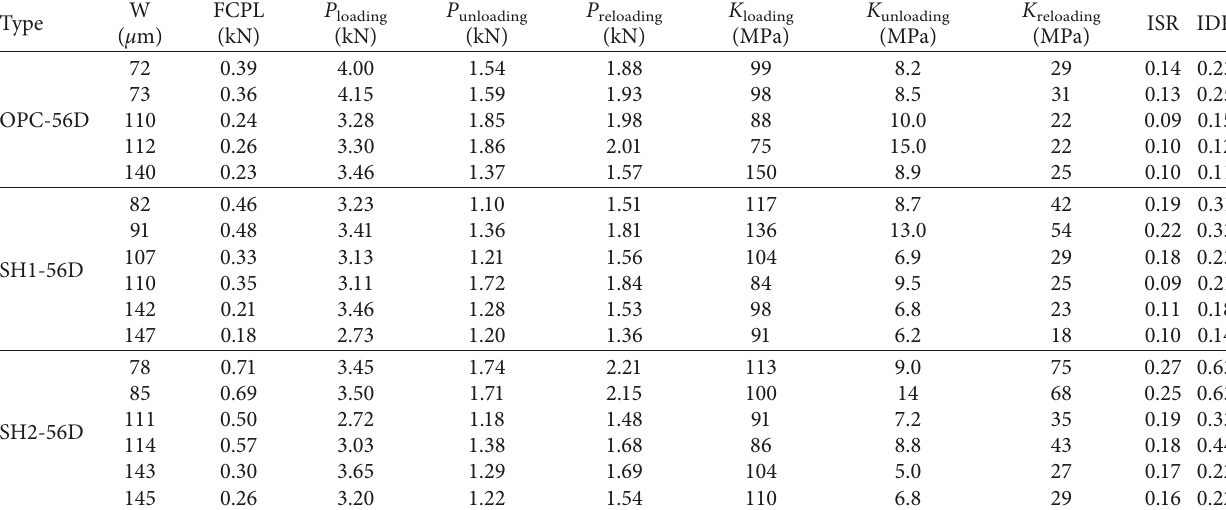
Table 3: Mechanical recovery indices for three mixes at 56days of